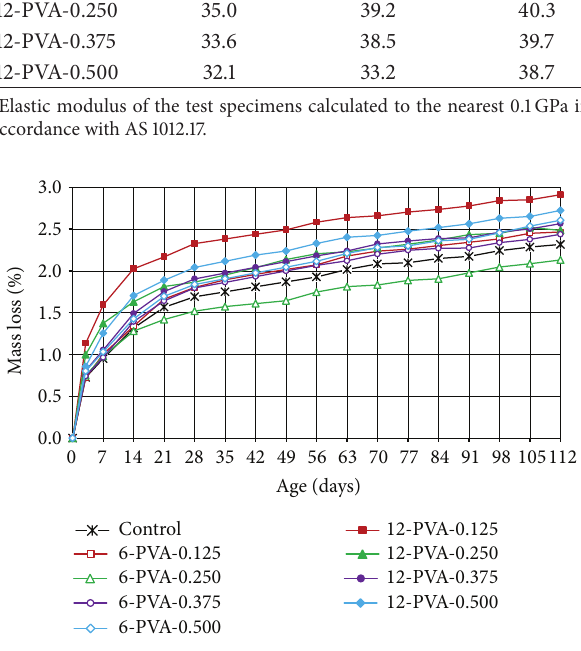
Figure 6: Water loss proportion to specimen initial total mass.